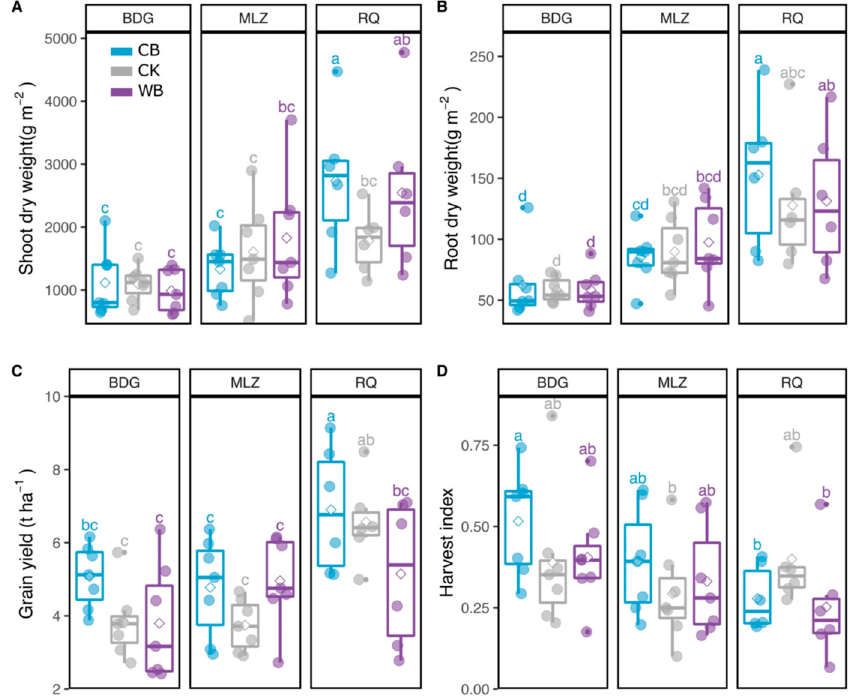
Figure 2. Effects of biochar on plant shoot dry weight ( A ), root dry weight ( B ), grain yield ( C ), and harvest index ( D ) in sandy clay loam (BDG and MLZ) and silty clay loam (RQ) soils. Error bars (standard error) followed by a different letter within each column are significantly different at p < 0.05 using the Duncan